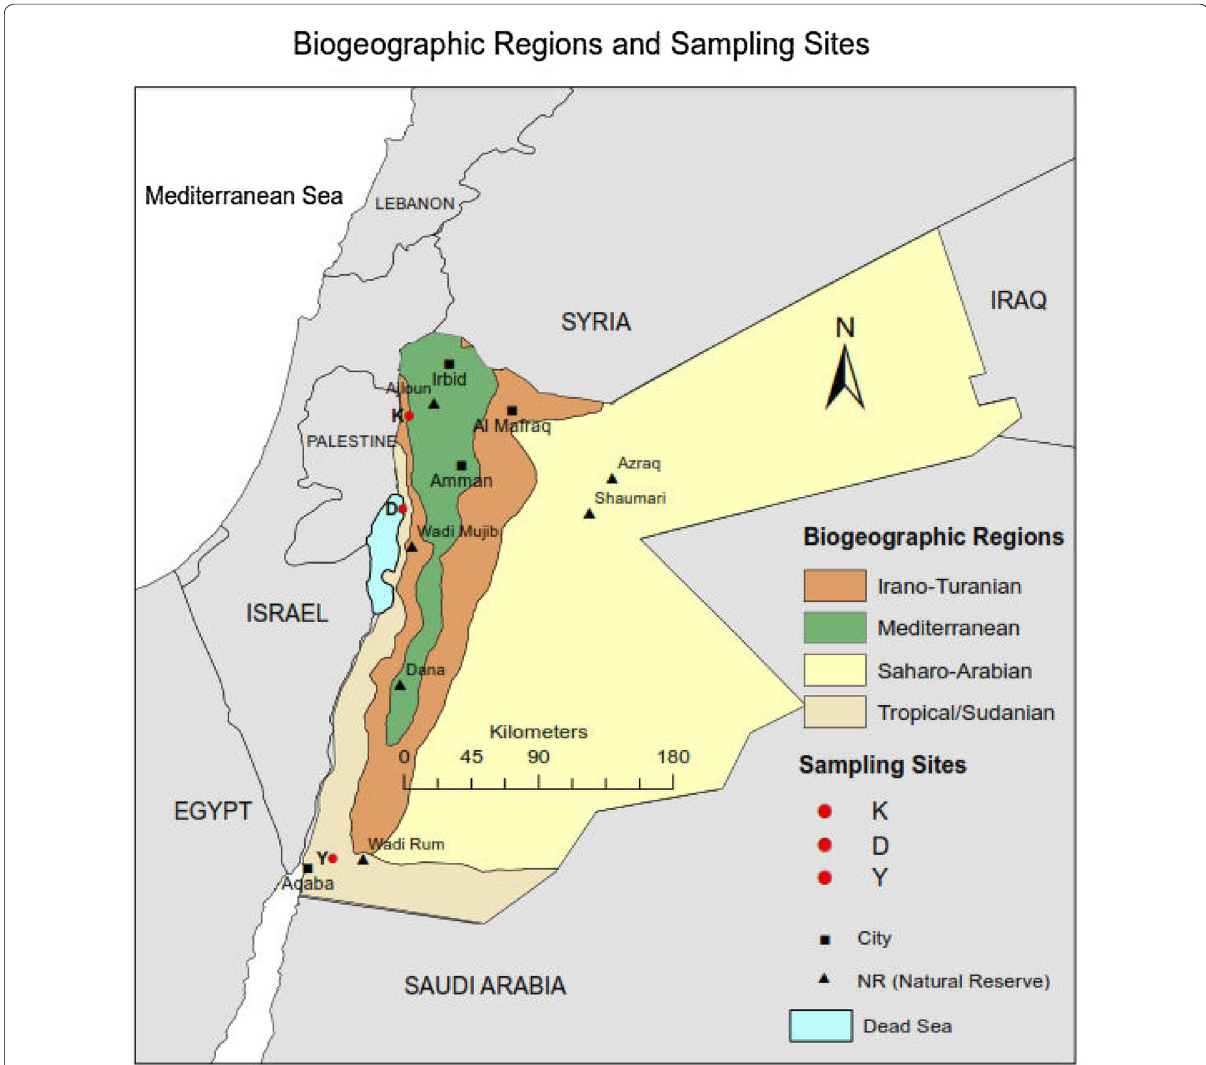
Fig. 1 Map of Jordan biogeography and locations of sampling sites for Blepharis . Sampling sites are indicated by red circles. K, Kufranjah valley; D, Dead Sea region; Y, Wadi al